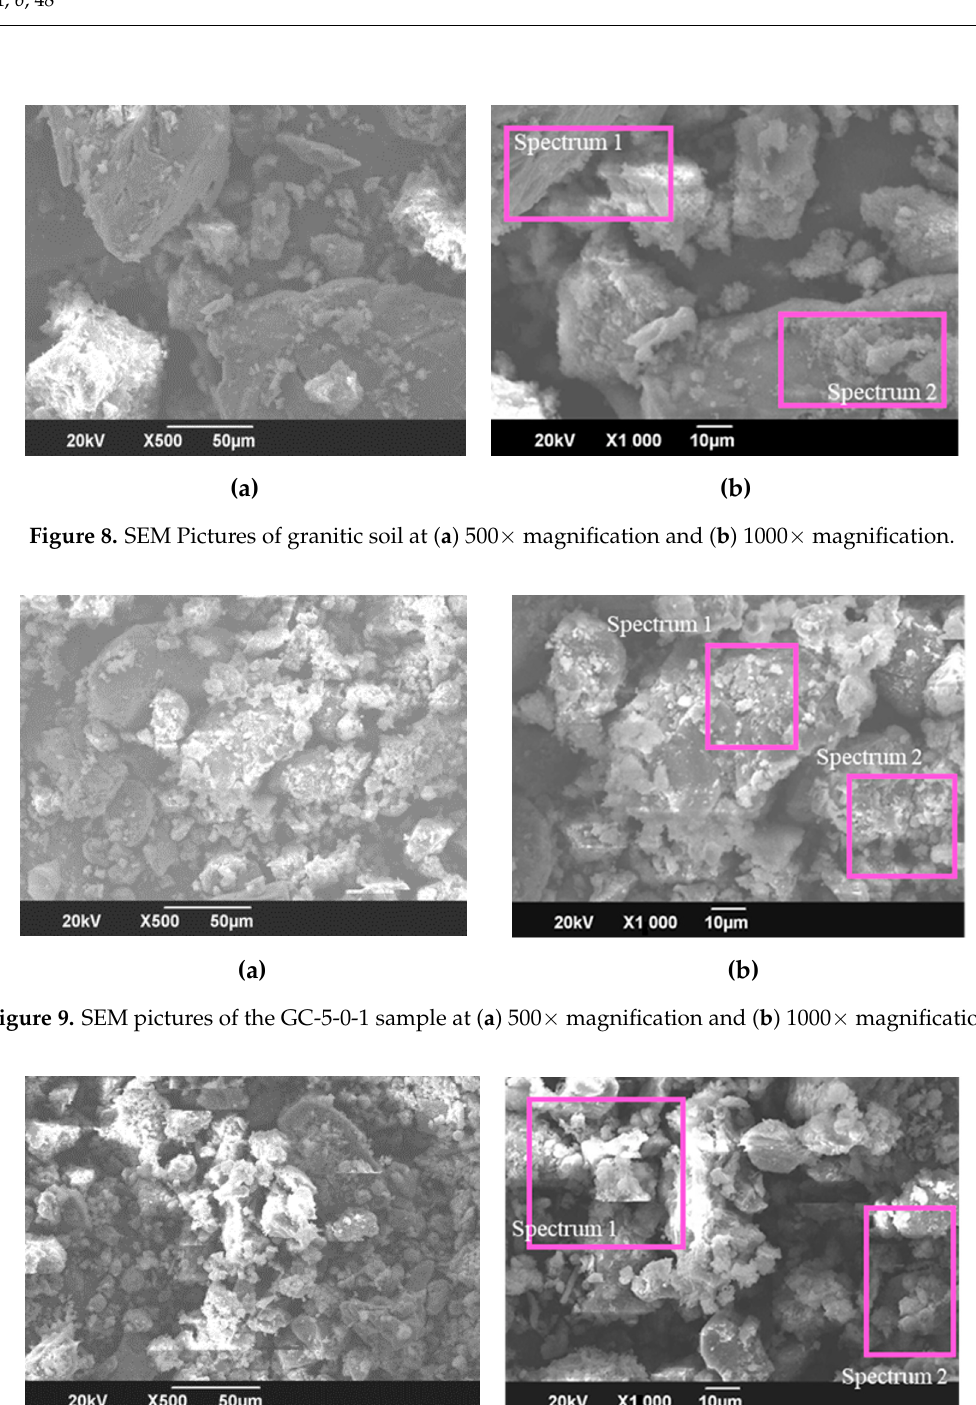
256 257 Figure 7. Unconfined compression strength of the granitic–cement samples.